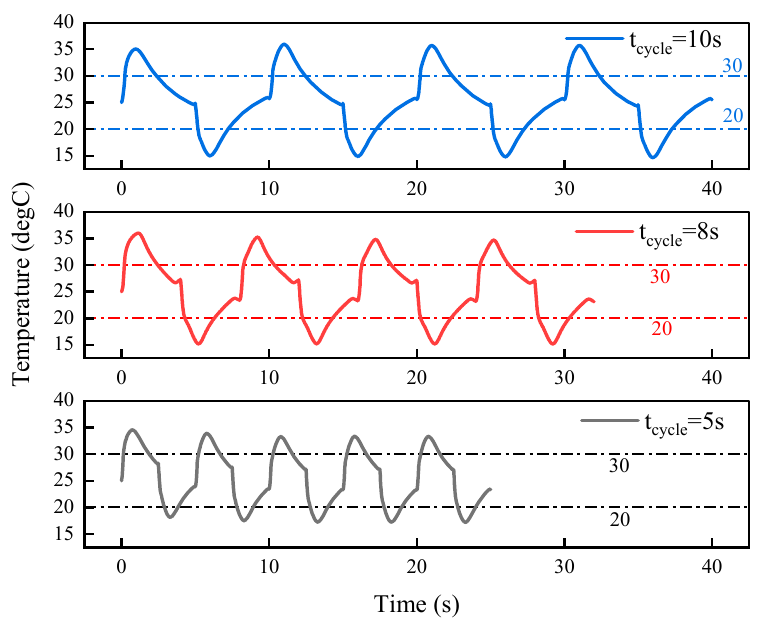
Figure 14. Temperature variation trend of fluid at different cyclic periods.